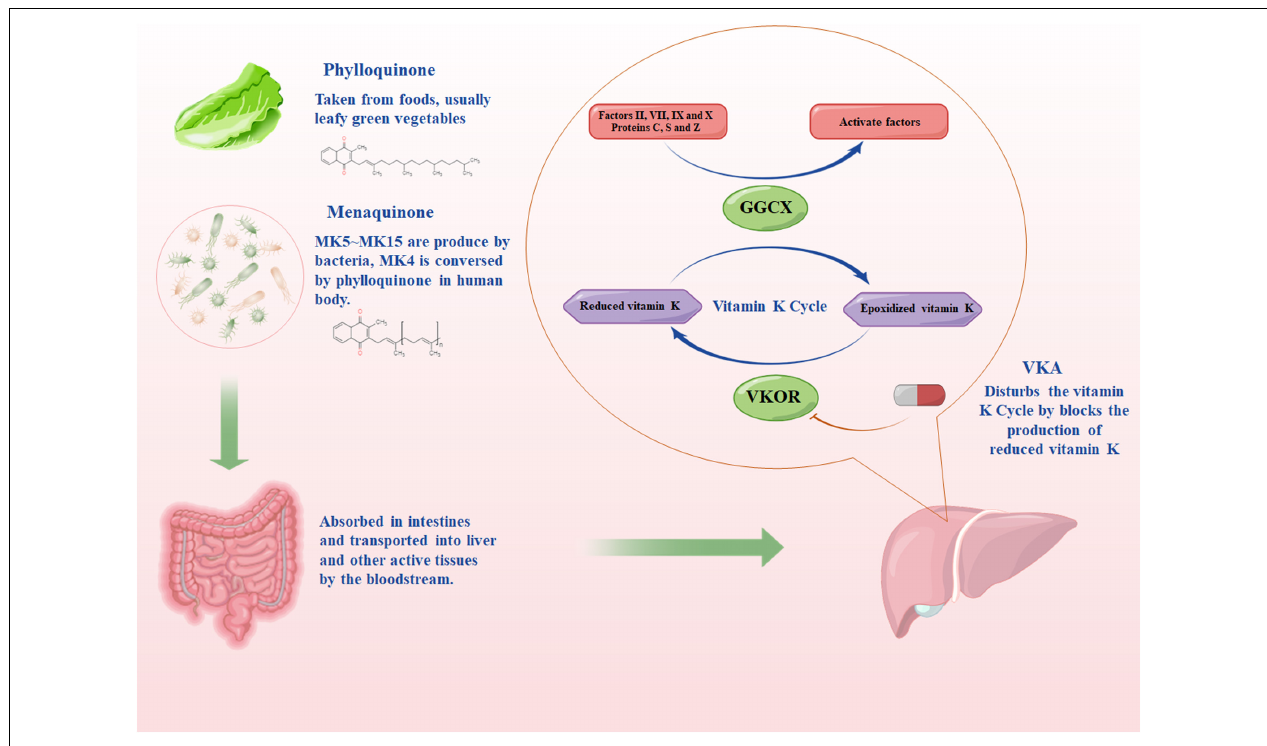
FIGURE 1 | The source of vitamin K and the pharmacodynamic pathway of vitamin K antagonist. MKn, menaquinone, n is the number of isoprenoid units; GGCX, the gamma-glutamyl carboxylase enzyme; VKOR, vitamin K epoxide reductase. The figure was drawing by Microsoft PowerPoint 2016, and the materials were provided by Figdraw